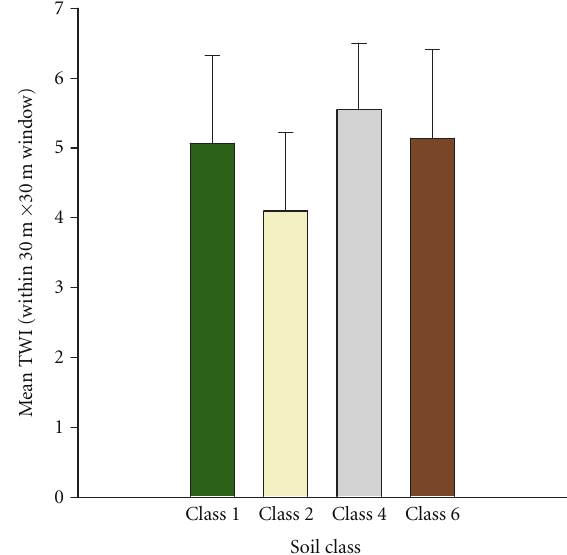
Figure 4: Mean Topographic Wetness Index (TWI) values sum- marized within 6 × 6 (5m) pixel windows for each of four soil classes across the 150ha study area. Three classes were mapped using a combination of unsupervised and supervised classification methods, and the fourth class (soil class 4) was identified as an ephemerally flooded playa by Monger et al. [22]. Mean values are plotted with error bars representing one standard